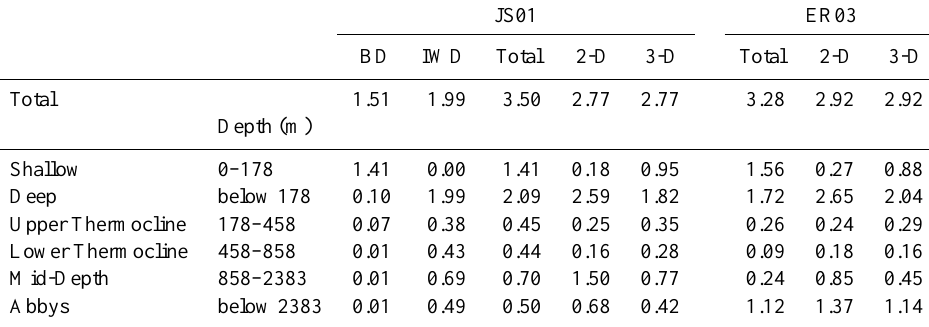
Table 1. Energy flux (TW) out of the barotropic tide estimated by JS01 and ER03 for different depth ranges. Note that JS01 provides separation between bottom drag (BD) and internal wave drag (IWD), whereas ER03 does not. The subcolumns on the left are based on calculations on the original 1/2 ◦ grid for JS01 and on a 1/6 ◦ grid for ER03. The subcolumns on the right denote fluxes averaged on the climate model grid without (2-D) and with (3-D) the consideration of subgrid-scale bathymetry. The depth levels are based on the climate model grid.